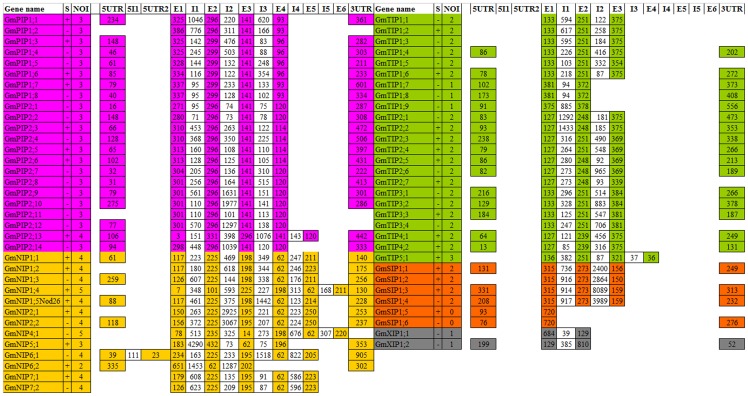
Exon-intron structure analysis of 66 soybean aquaporins.S stands for strand, NOI for number of introns, E for exon and I for intron.